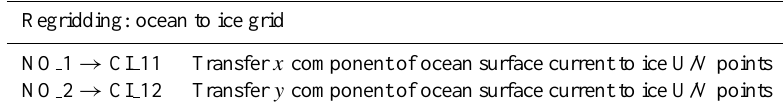
Table 2a. Details of regridding the ocean fields onto the ice U/V points in Fig. 5. These manipulations are in the NEMO subroutine CICE SBC IN